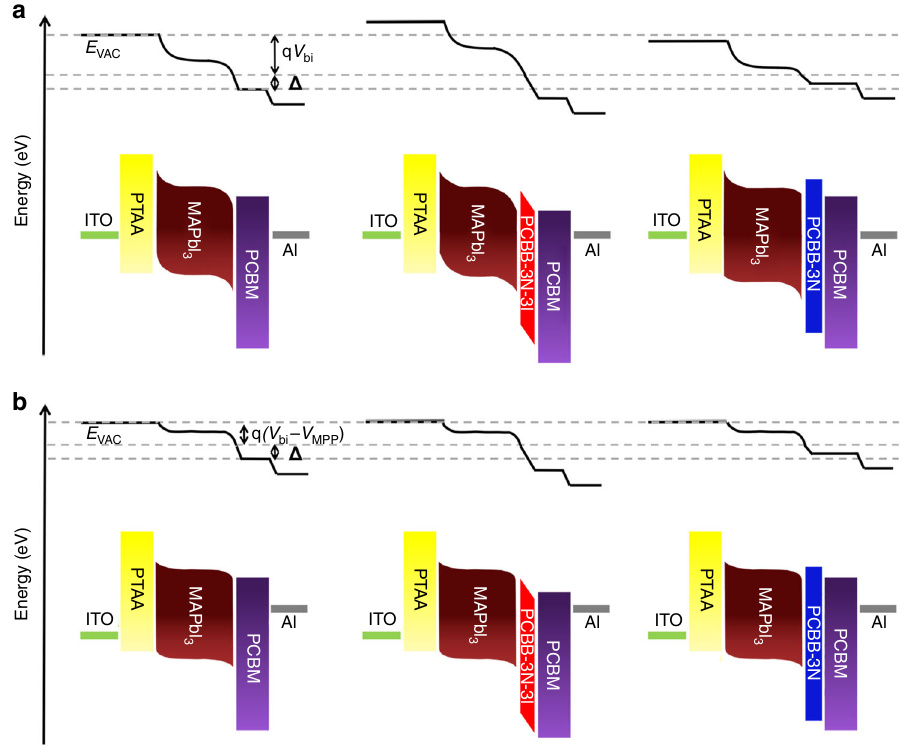
Fig. 4 Energy band structure of pero-SCs a in SCC and b MPP. Here, energy band alignment refers to the interfacial energy level offset. Both built-in potential and interfacial dipole moment improve with PCBB-3N-3I dipole interlayer and deteriorate with PCBB-3N